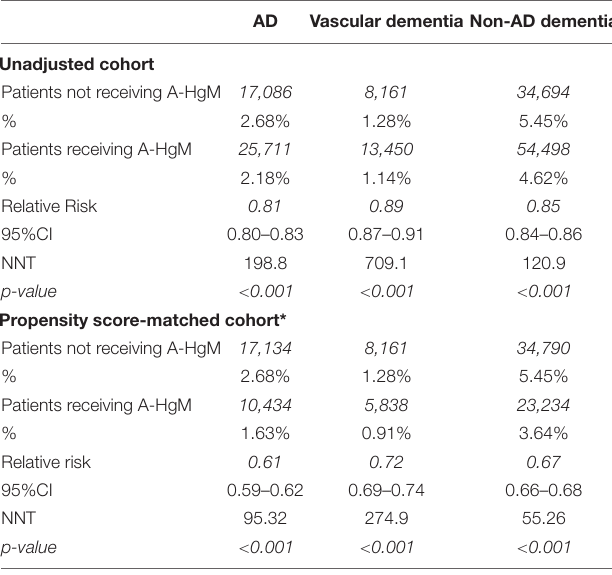
TABLE 6 | Incidence and relative risk of patients taking anti-hyperglycemic medication to develop AD and ADRD. AD Vascular dementia Non-AD dementia